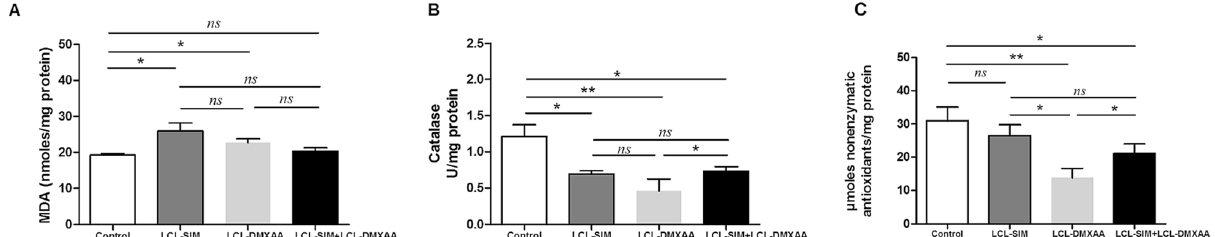
Figure 5. Effects of different liposomal treatments with SIM and DMXAA on tumor oxidative stress parameters. ( A ) MDA concentration expressed as nmoles MDA/mg protein; ( B ) Catalase activity expressed as U/mg protein; ( C ) TAC expressed as μmoles Trolox/mg protein. All parameters were measured in tumor lysates from mice treated with LCL-SIM and LCL-DMXAA as single or combined therapy. Data represent the mean ± SD of duplicate measurements ( ns , P > 0.05; *, P < 0.05; **, P < 0.01). Control—LCL-treated group; LCL-SIM—experimental group treated with 5 mg/kg SIM as liposome-encapsulated form; LCL-DMXAA— experimental group treated with 14 mg/kg DMXAA as liposome-encapsulated form; LCL-SIM + LCL- DMXAA—experimental group treated with 5 mg/kg SIM and 14 mg/kg DMXAA as liposome-encapsulated forms. The graphs were generated using GraphPad Prism 9.2.0.332 (Serial number: GPS-2216002-E###-#####, MachineID: 3383874FBDD) (https:// www. graph pad.